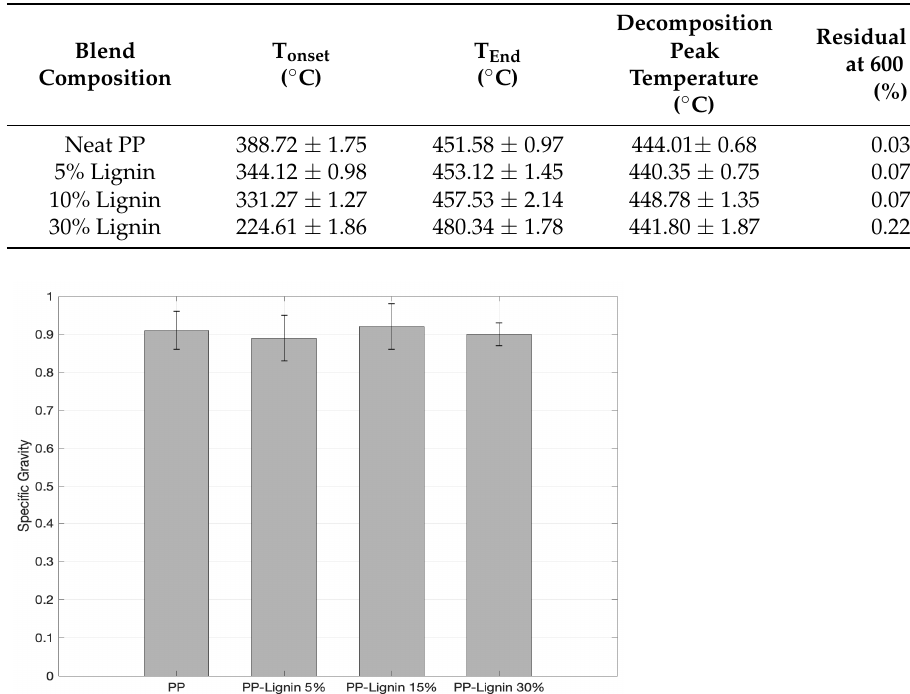
Figure 6. DTGA curves of different blends of PP-Lignin. Table 3. Temperatures and Char Residue Characteristics of PP-Lignin Composties.